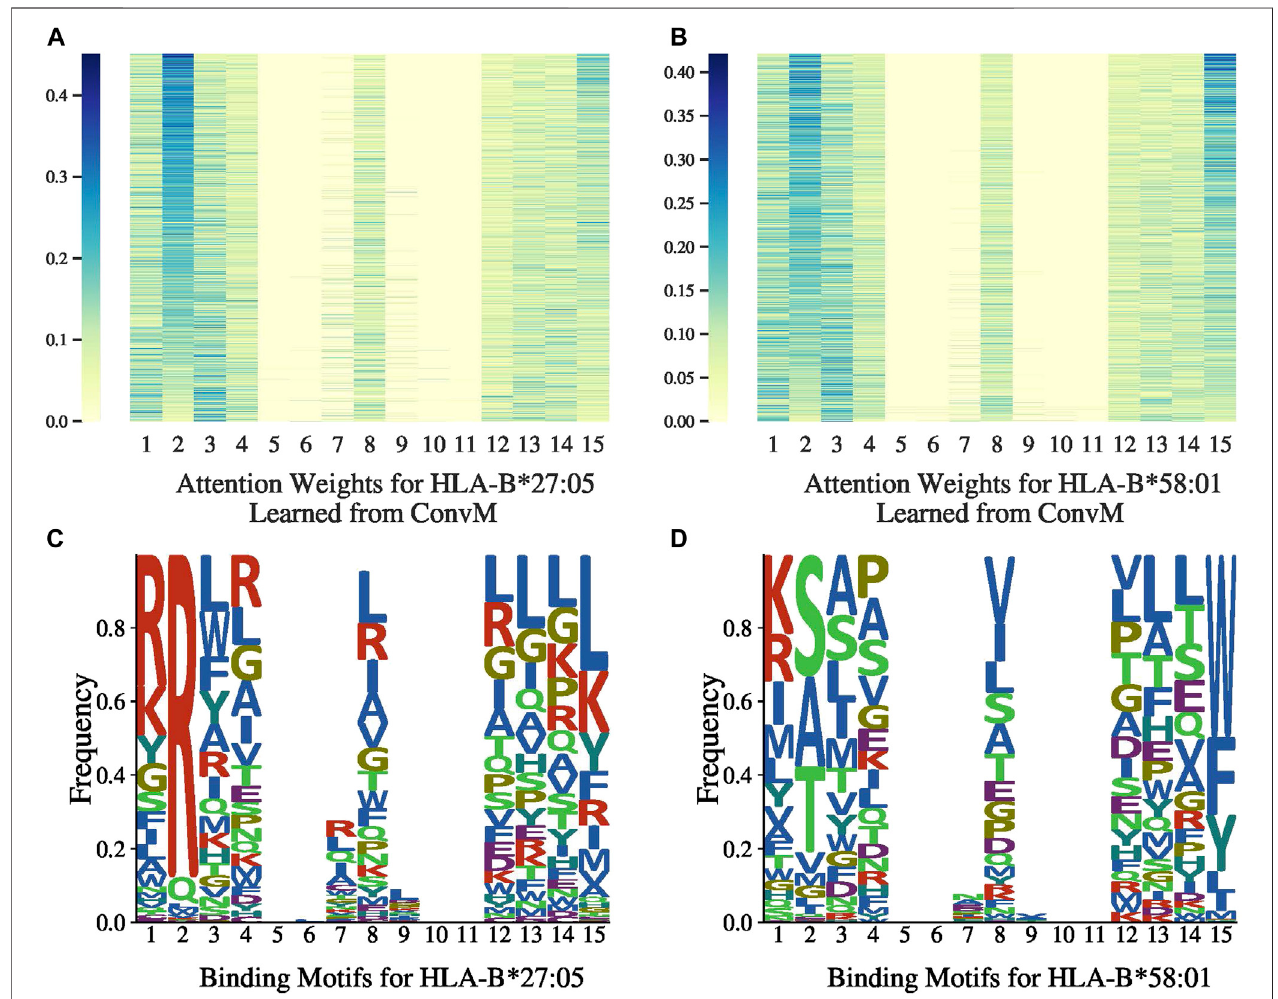
FIGURE 4 | Attention weights and motifs for HLA-B*27:05 and